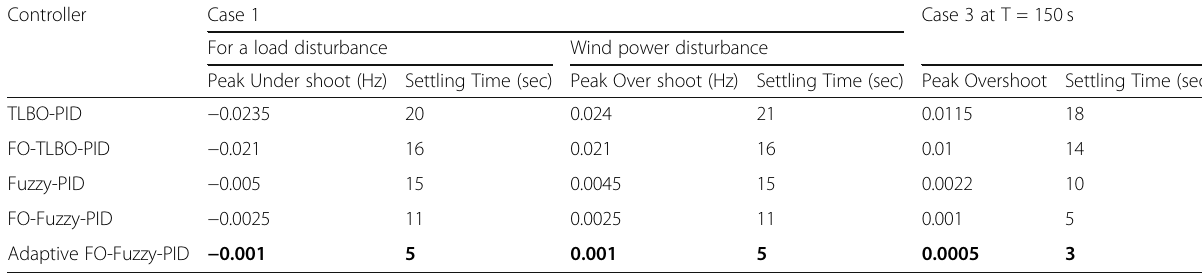
Table 2 Comparative study of various controllers for case 1 & 2 Controller